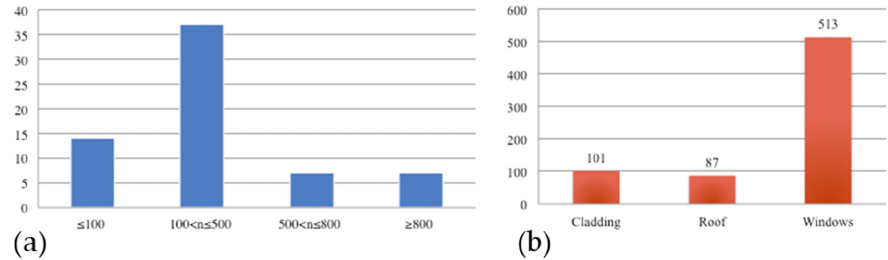
Figure 6. Number of interventions as a function of cost per floor area (€/m 2 , ( a )) and the cost per square meter of the interventions’ surface area (€/m 2 , ( b )).